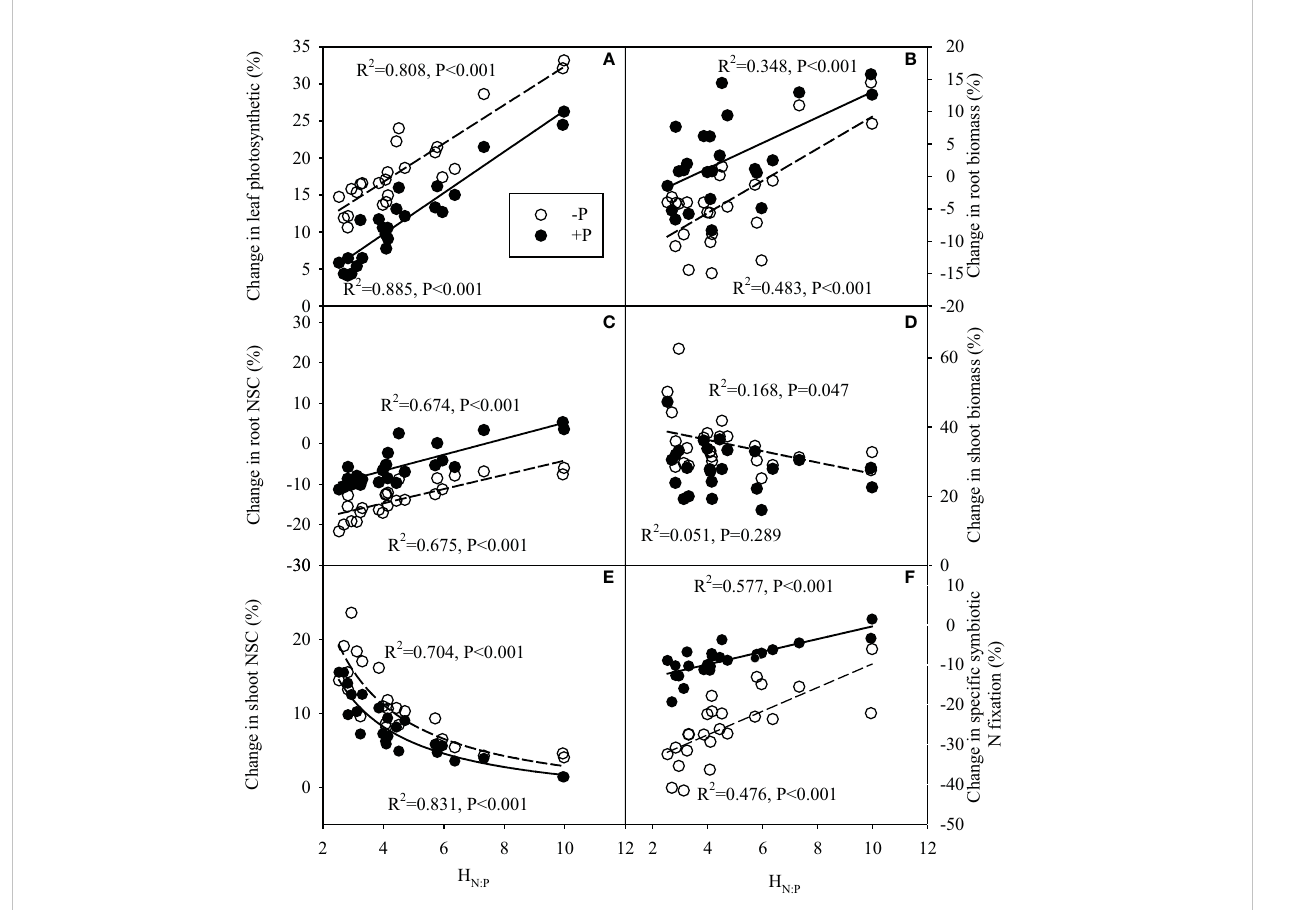
FIGURE 8 Correlation relationships between stoichiometric homeostasis of plant N:P (H N:P ) of legume species and its change in leaf photosynthetic rate (A) , root biomass (B) , root non-structural carbohydrate (NSC) concentration (C) , shoot biomass (D) , shoot non-structural carbohydrate (NSC) concentration (E) and %Ndfa (F) under N addition with or without P